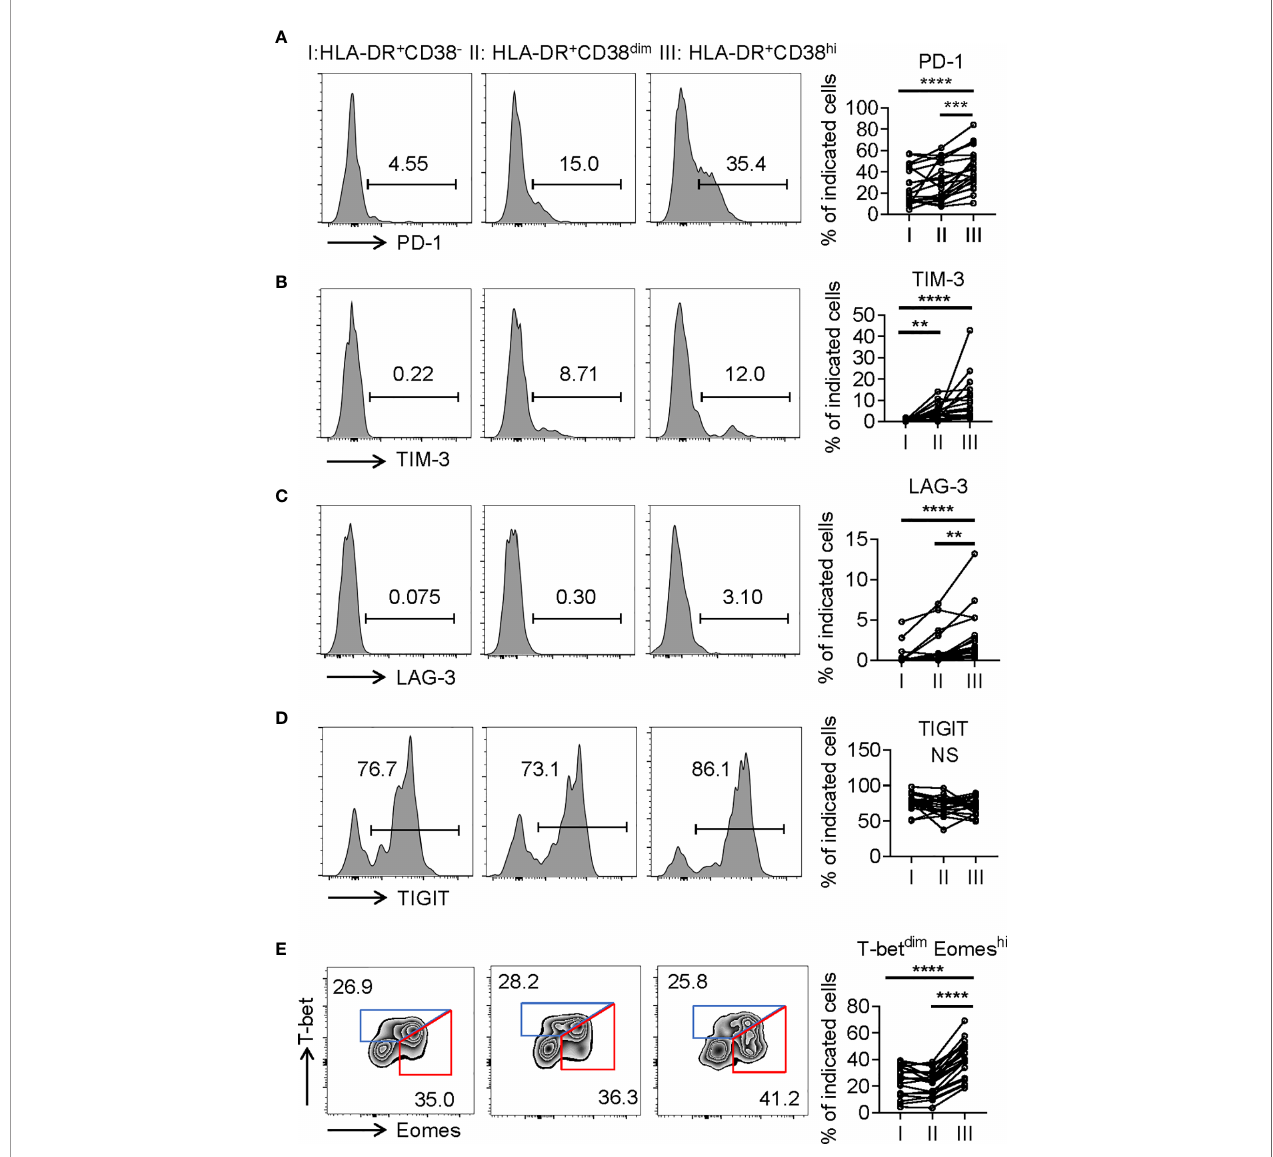
FIGURE 4 | HLA-DR + CD38 hi CD8 + T cells displayed phenotypic and transcriptional state of exhaustion. (A – D) Flow cytometry analysis of expression of PD-1 (A) , TIM3 (B) , LAG3 (C) , and TIGIT (D) on the three CD8 + T population (I, II, III) from COVID-19 patients (n = 20). Representative histograms (left) and plots (right) were shown. (E) Representative fl ow data (left) and dot plots (right) of percentage of T-bet dim Eomes hi and T-bet hi Eomes dim cells among I, II, III from COVID-19 patients (n = 20). P Values were obtained by paired two-tailed Student ’ s t tests and repeated measures by one-way ANOVA test followed by Holm-Sidak ’ s multiple comparisons test. **p < .01, ***p < .001, ****p <